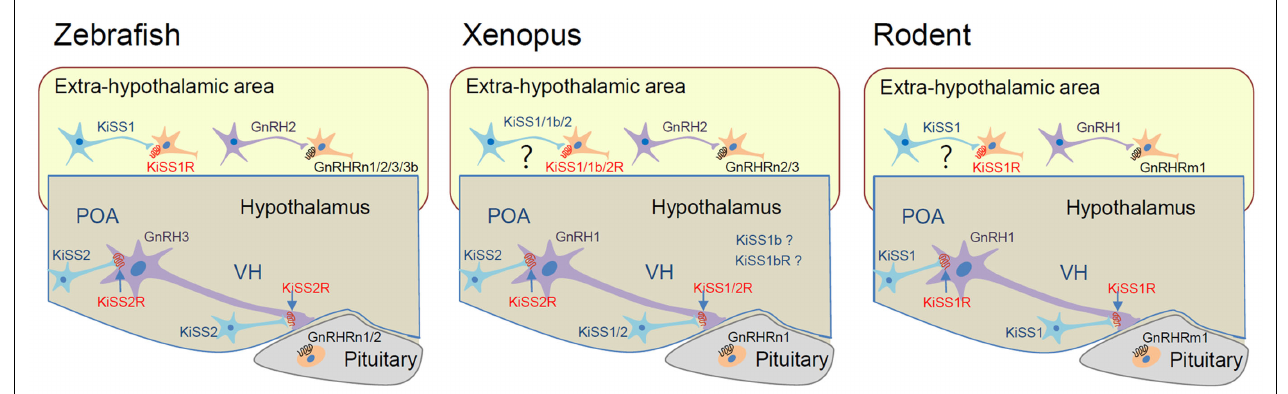
and GnRH2 may conduct extrahypothalamic functions through KiSS1R and GnRHRs. GnRH3 action on the pituitary is likely mediated by GnRHRn1 and n2 forms that have relatively high affinity for GnRH3. In Xenopus , both KiSS1 and KiSS2 are likely involved in HPG axis control. Function of KiSS1b and KiSS1bR has not been demonstrated.The GnRHRn1 form in the pituitary may interact with GnRH1 to mediate hypothalamo-pituitary